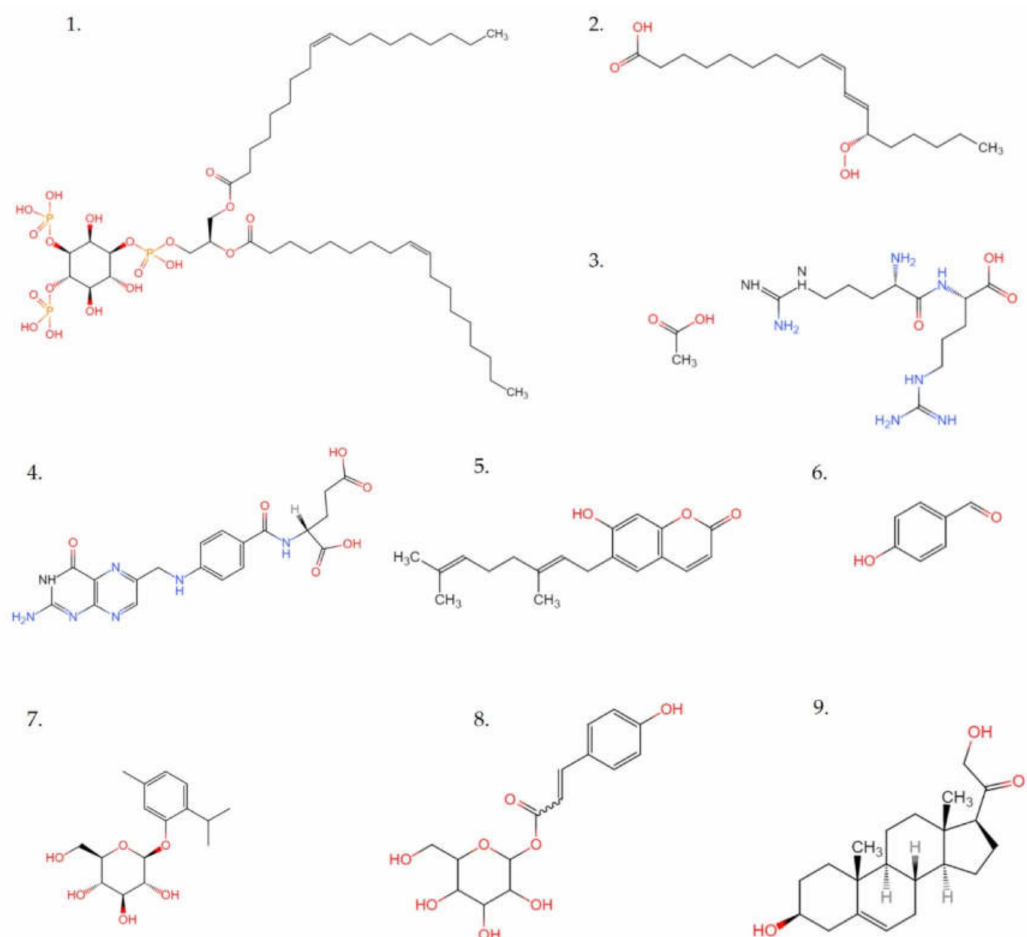
Figure 9. Chemical structures of representative compounds identified in the EAF fraction of crude extract from quinoa by UPLC-MS/MS. 1 : 1,2-dioleoyl-sn-glycero-3-phospho-(1 (cid:48) -myo- inositol-3 (cid:48) ,4 (cid:48) -bisphosphate); 2 : 13s-hydroperoxy-9z,11e-octadecadienoic acid; 3 : Arg-Arg; 4 : Fo- late; 5 : Ostruthin; 6 : 4-hydroxybenzaldehyde; 7 : Thymol-beta-d-glucoside; 8 : Coumaroyl